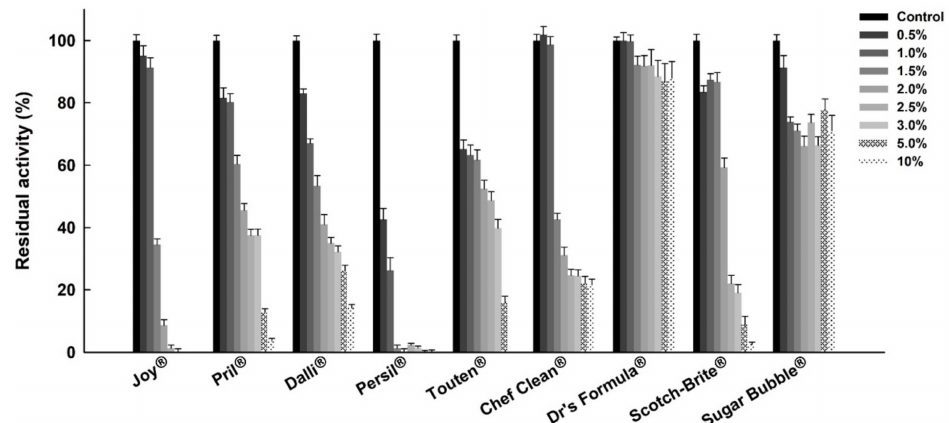
Figure 2. Effects of some brands of liquid detergents on the esterase activity of His 6 -tagged Bd PTE. The enzyme samples were pre-incubated at ambient temperature for 1 h before activity assays. The esterase activity in the absence of detergents was used as a control (100%).